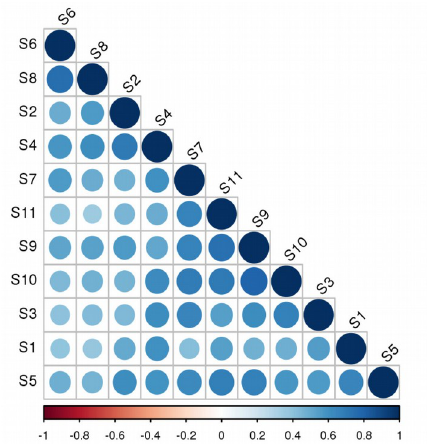
Figure 6. The complete correlation rank of S1-S11. Correlation coefficients are replaced by symbols according to the value (darker dots show stronger correlations)